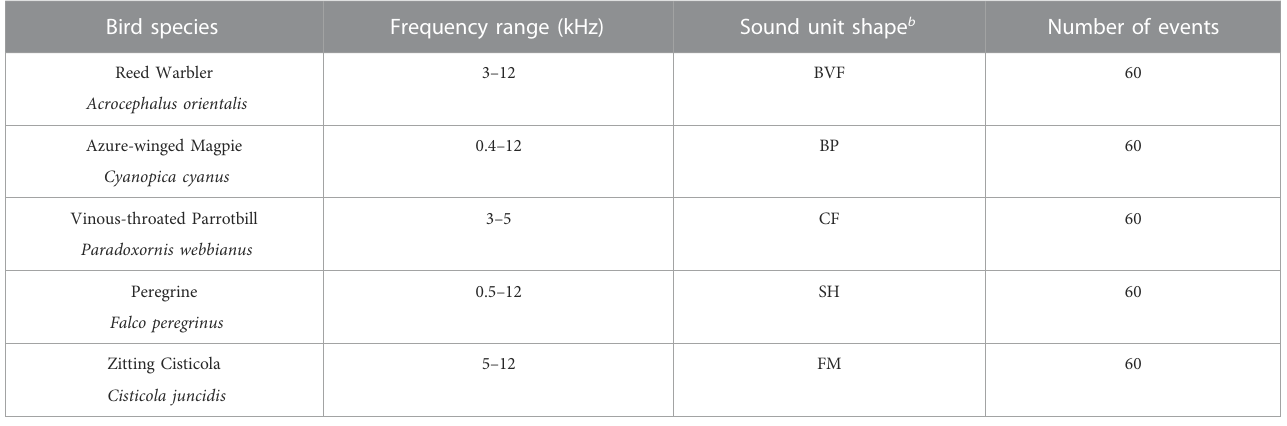
TABLE 1 Details of species and acoustic events used in this work. The fi ve species are common and widespread in Xuzhou. All the acoustic events a were extracted from our fi eld recordings.